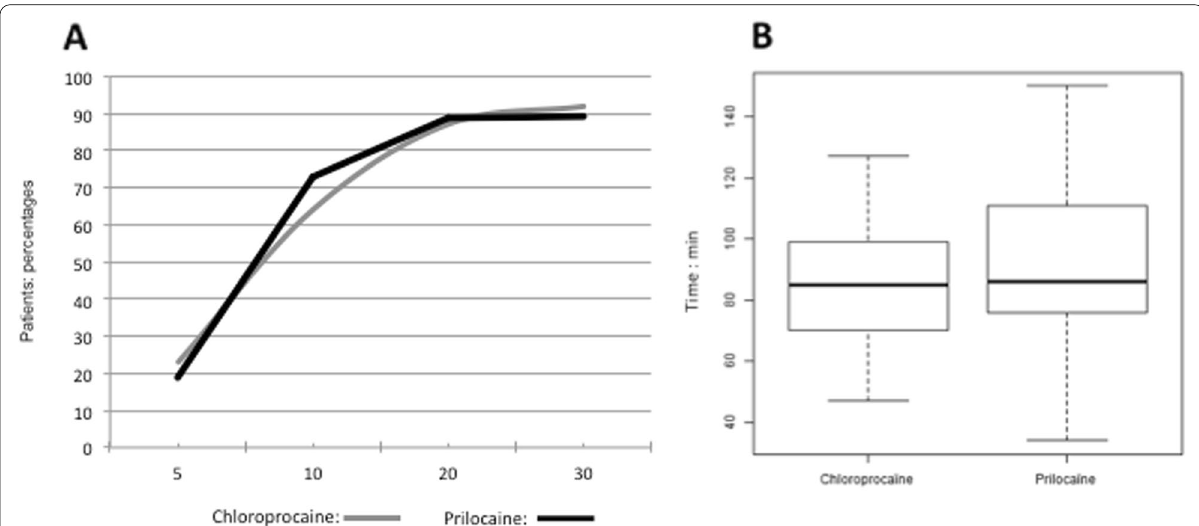
Fig. 5 a Percentage of patients with a complete motor block (Bromage 3) during the first 30 min after local anesthetics injection. b Time to obtain complete recovery of motor block (Bromage 0). Statistically significant differences are marked with *( P <